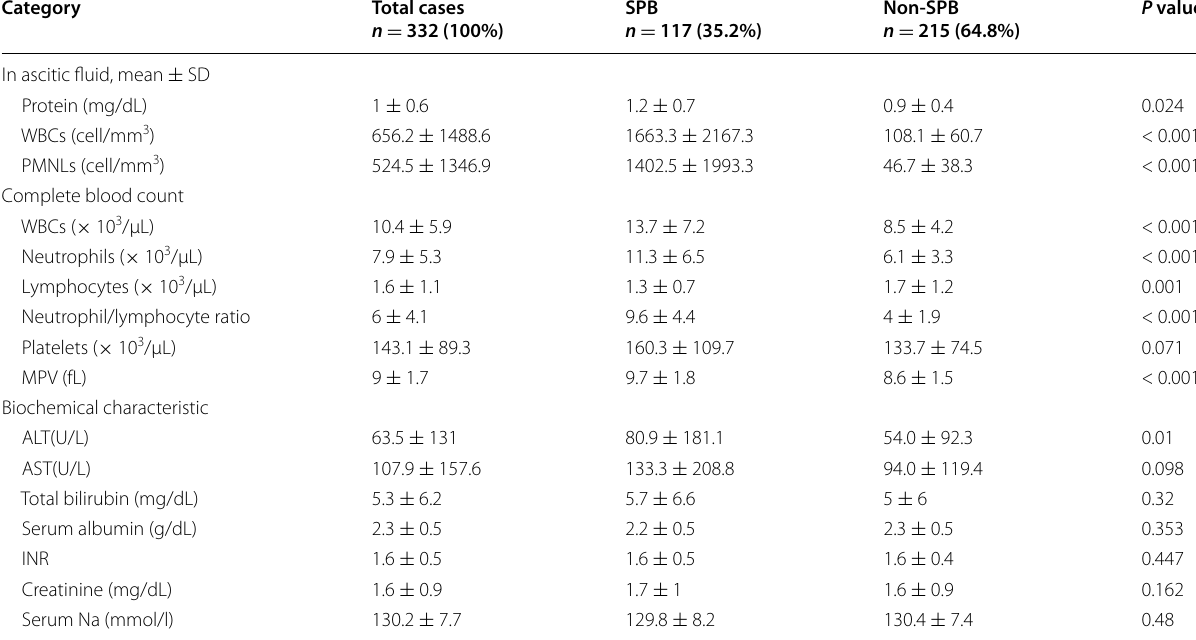
Table 2 Laboratory parameters of the studied cohort